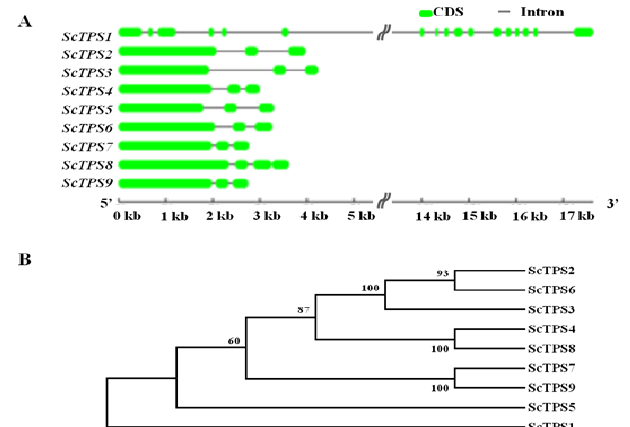
Figure 1. Gene structure of the trehalose-6-phosphate synthase ( TPS ) gene family ( A ) and phylogenetic tree ( B ) based on multiple sequence alignment of TPS protein in sugarcane. Part of nucleotide sequence in ScTPS1 intron is omitted marked with double wave line. The bootstrap value in which the associated taxa clustered together are shown next to the branches.